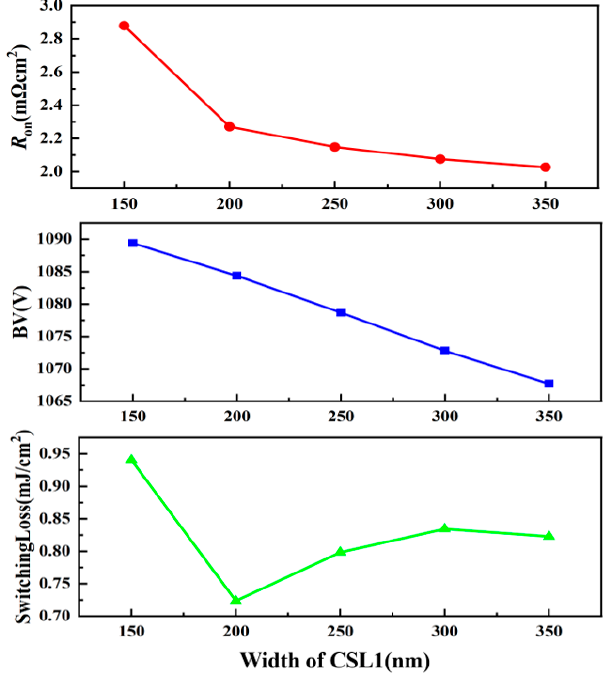
Figure 3. The influence of the width of CSL1 ( W c1 ) on the Ron ( V GS = 15 V), BV ( V GS = 0 V) and switching loss.